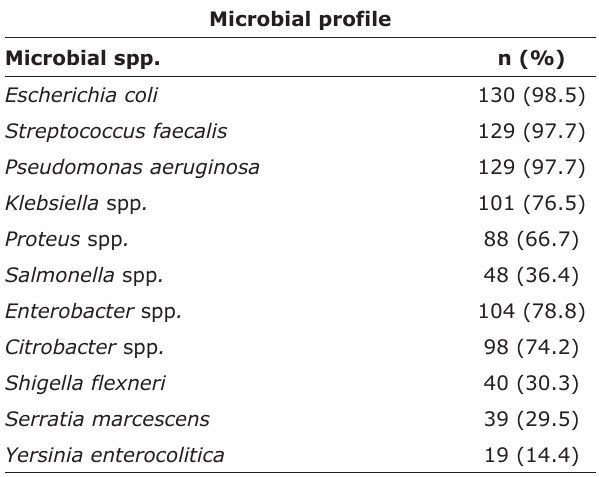
Table-2: Frequency number (%) of farms from which each microbe was isolated and identified. Microbial profile Microbial spp.